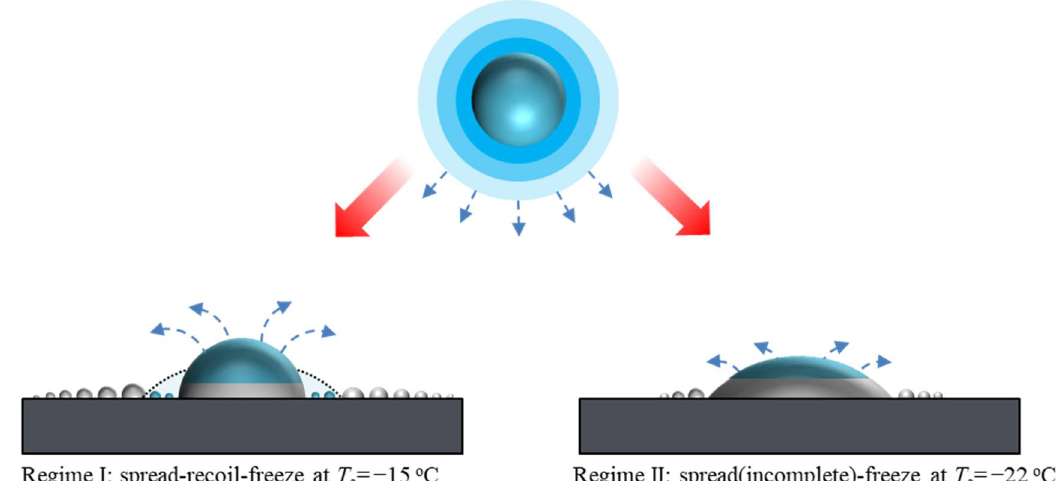
Figure 7. Schematics of the vapor transfer from an impinging drop to the surrounding substrate at two different freezing regimes.